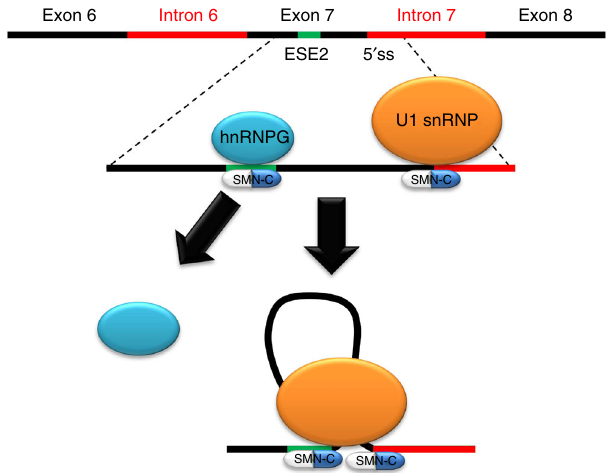
Fig. 7 Working model of the proposed molecular interactions of the SMN-C type SMN2 splicing modi fi ers. SMN-C type compounds bind to two sites at the SMN2 exon 7, namely ESE2 and 5 ′ ss when U1 snRNA is bound. Whereas interaction with the 5 ′ ss drives promotion of exon 7 inclusion in the splicing process, binding to ESE2 results in hnRNP G dislocation and allows the U1 snRNP complex to bind to ESE2. Both binding processes in combination provide high selectivity to the SMN2 and STRN3 pre-mRNAs over other